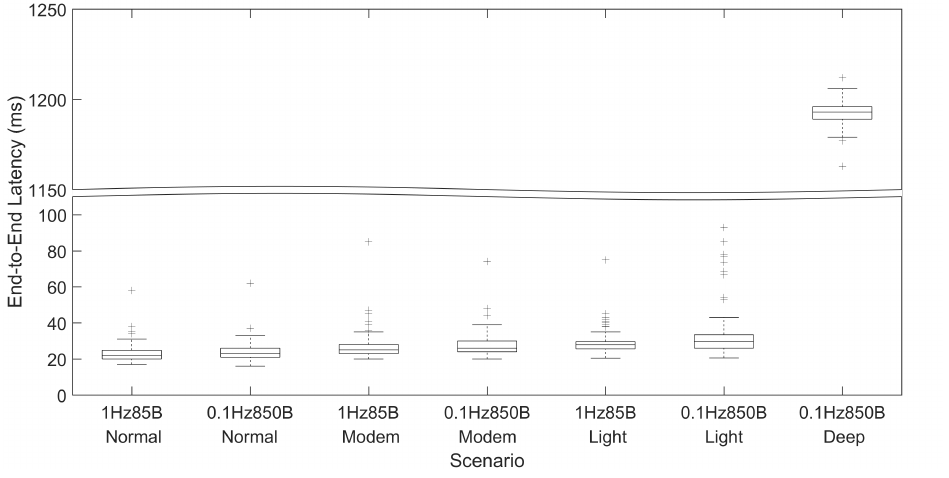
Figure 6. End-to-end latency measured for each scenario.